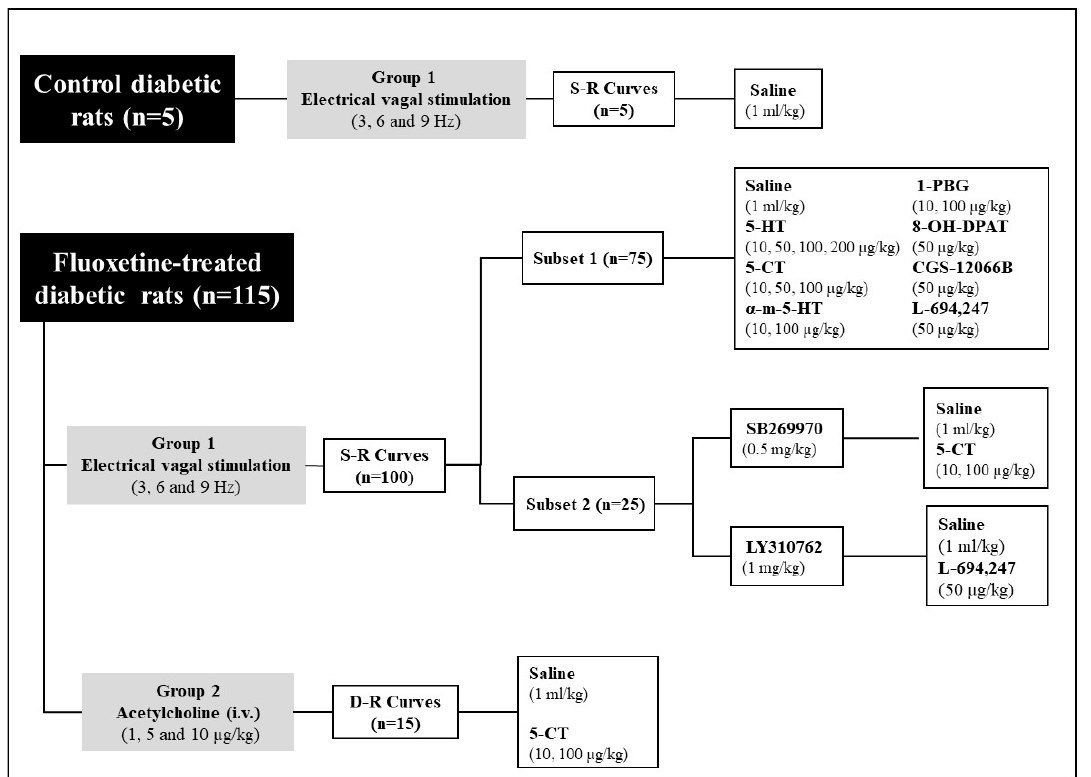
Figure 5. Experimental protocols showing the number of animals used. Experimental protocols showing the number of animals used in the control diabetic group and 2 main groups of fluoxetine-treated diabetic rats and in the different subsets used in the present study. Bradycardic responses were obtained by electrical vagal stimulation (groups 1 of control and fluoxetine-treated diabetic rats) or i.v. bolus of acetylcholine (group 2 of fluoxetine-treated diabetic rats). All drugs were administered as i.v. bolus.